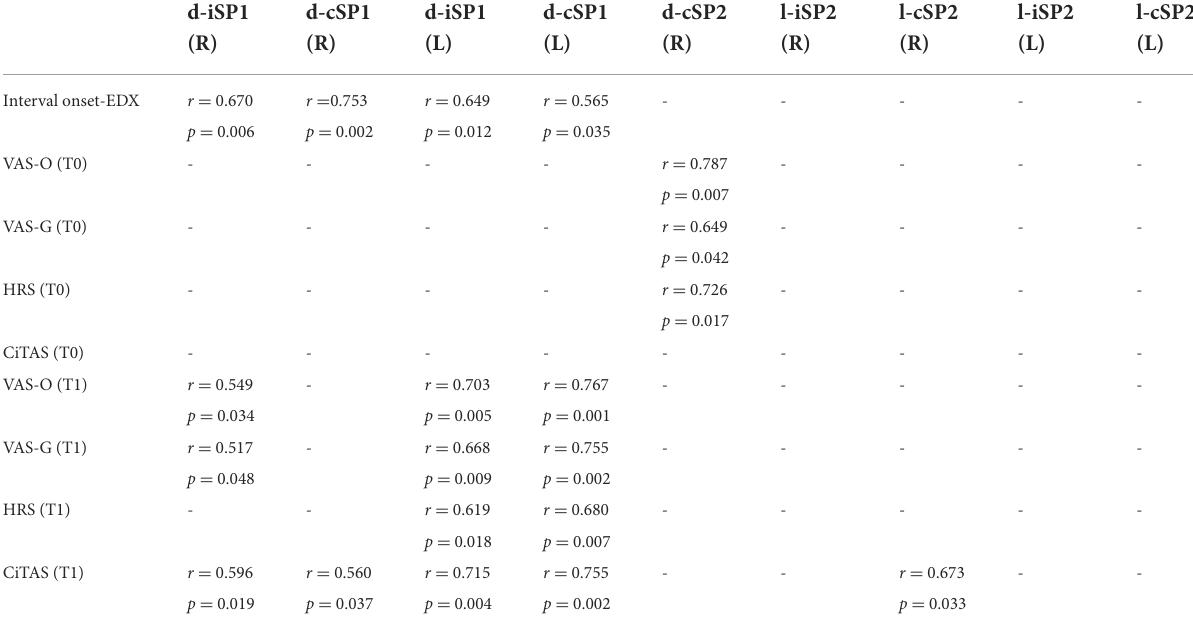
Pearson’scorrelationcoefficients(r)andp-valuesareshowed. CiTAS, Chemotherapy Induced Taste Alteration Scale; cSP1: contralateral early silent period; cSP2, contralateral late silent period; d, duration; EDX, electrodiagnostic examination; HRS, Hyposmia Rating Scale; iSP1, ipsilateral early silent period; iSP2, ipsilateral late silent period; l, latency; L, left stimulation; R, right stimulation; T0, baseline assessment; T1,